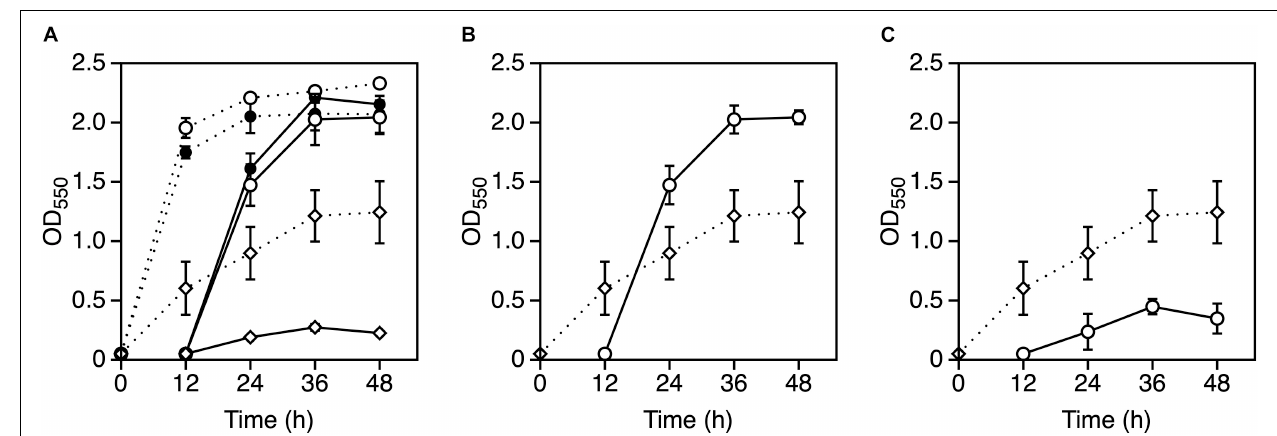
FIGURE 5 | Effect of EDTA with Mg 2 + or K + on the growth of Zymomonas mobilis TISTR 548. (A) Cells were subjected to two-step cultivation (dotted line, first; solid line, second) in YPD medium with 0.01 mM EDTA (open circle), 0.05 mM EDTA (open diamond) or without EDTA (closed circle) at 38 ◦ C under a static condition. (B,C) At the first stage of cultivation, cells were cultured in YPD medium containing 0.05 mM EDTA (open diamond) at 38 ◦ C, and after 12 h, at the second stage of cultivation (open circle), 5 mM MgCl 2 (B) or 30 mM KCl (C) was added to YPD medium containing 0.05 mM EDTA. Values and error bars represent means and standard deviations, respectively, for triplicate